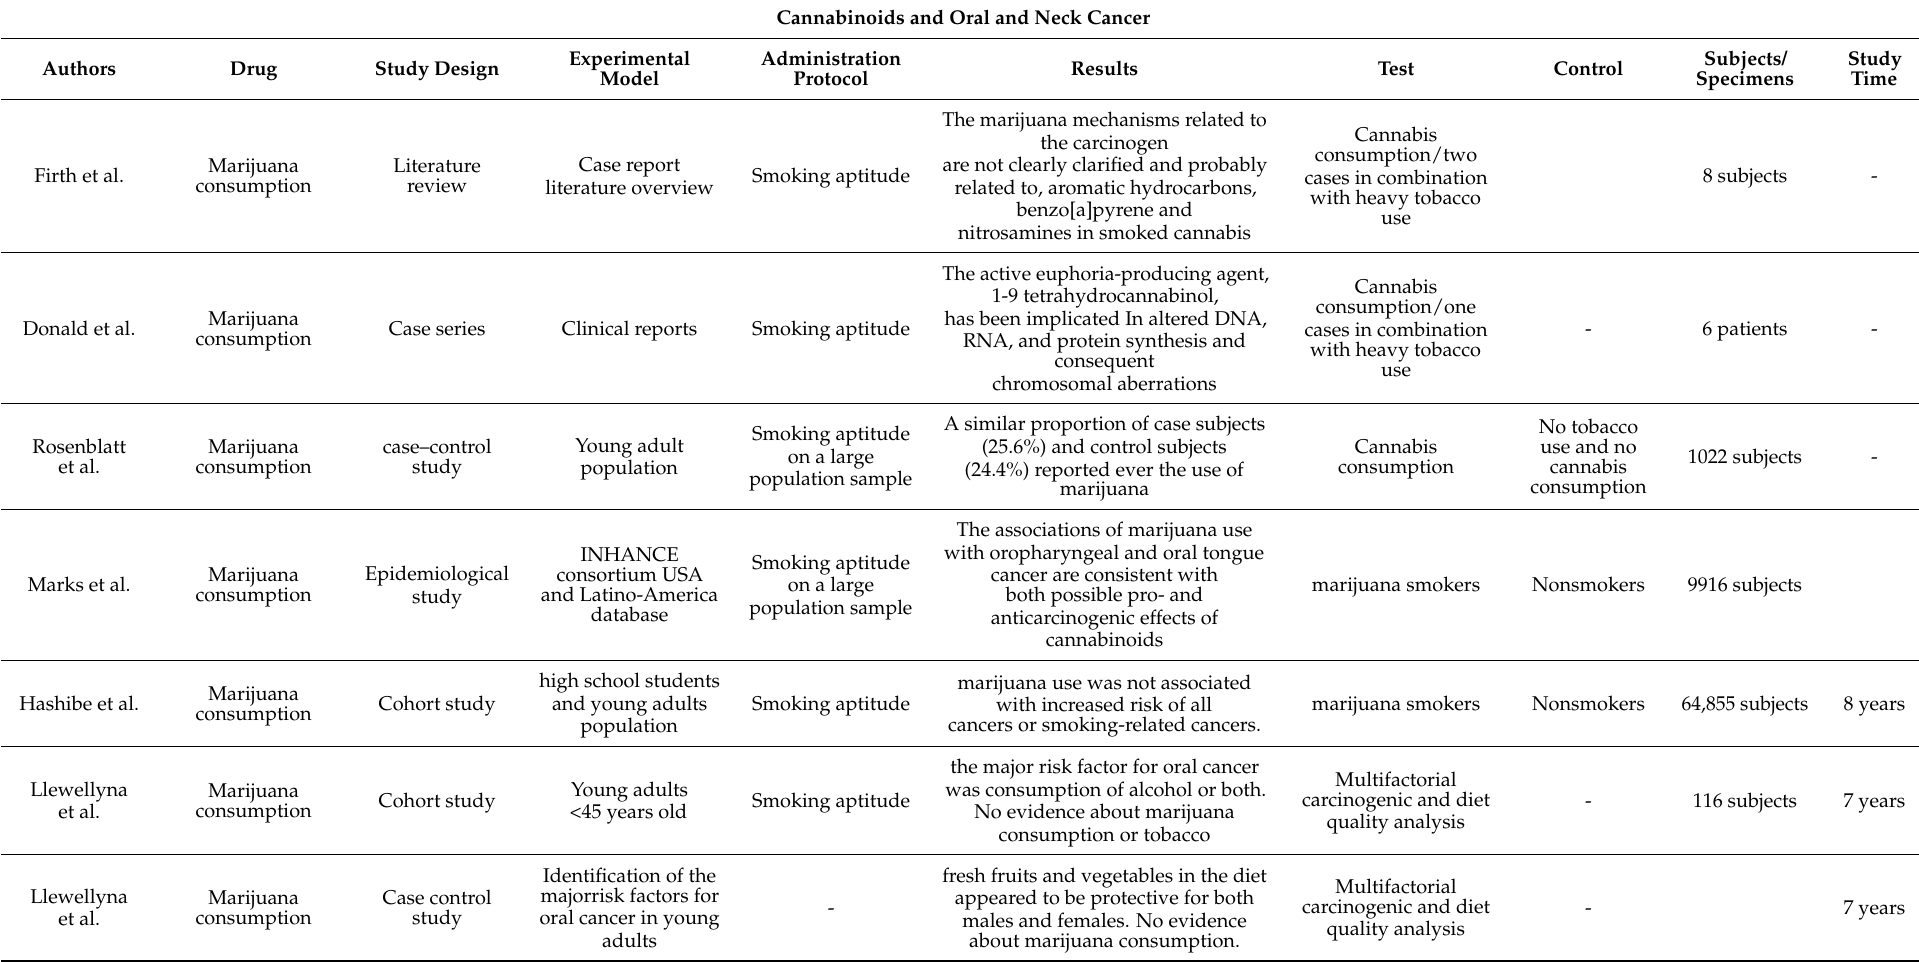
Table 6. Summary of the studies included according to the cannabinoids and oral and neck